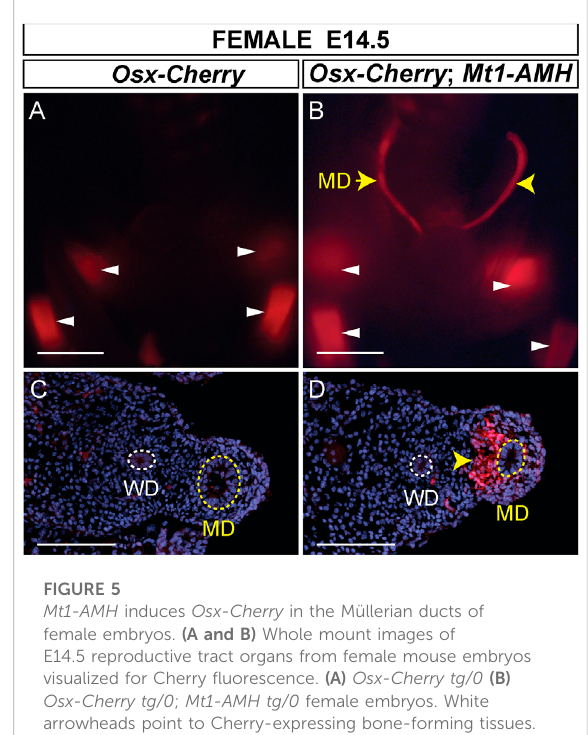
FIGURE 5 Mt1-AMH induces Osx-Cherry in the Müllerian ducts of female embryos. (A and B) Whole mount images of E14.5 reproductive tract organs from female mouse embryos visualized for Cherry fl uorescence. (A) Osx-Cherry tg/0 (B) Osx-Cherry tg/0 ; Mt1-AMH tg/0 female embryos. White arrowheads point to Cherry-expressing bone-forming tissues. Yellow arrowheads point to Cherry expression in the Müllerian ducts. (CandD) CrosssectionsthroughMüllerianducts,visualized for Cherry fl uorescence and counterstained with DAPI. (C) Osx- Cherry tg/0 (D) Osx-Cherry tg/0 ; Mt1-AMH tg/0 female embryos. Arrowhead in D points to Cherry-expressing Müllerian duct mesenchyme. MD, Müllerian duct (yellow dotted line); WD, Wolf fi an duct (white dotted line). Scale bars (A and B) = 1000 um; (C and D) = 100 um. Cherry tg/0 ; Mt1-AMH tg/0 female embryos, n =